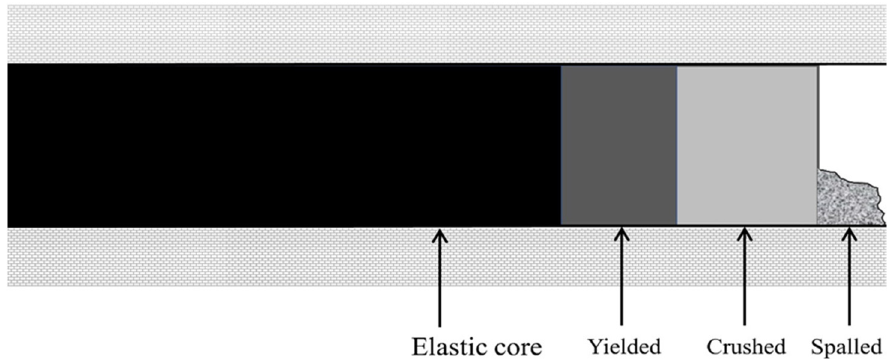
Figure 2. Coal rib failure zones development (modified from